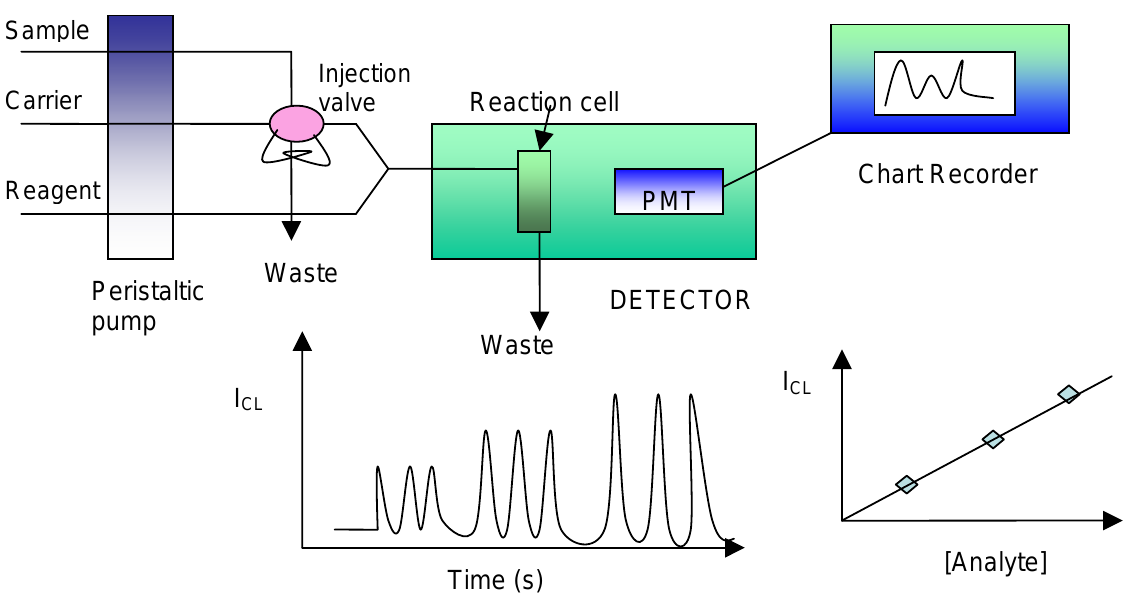
Figure 1. Schematic representation of a typical FIA-CL